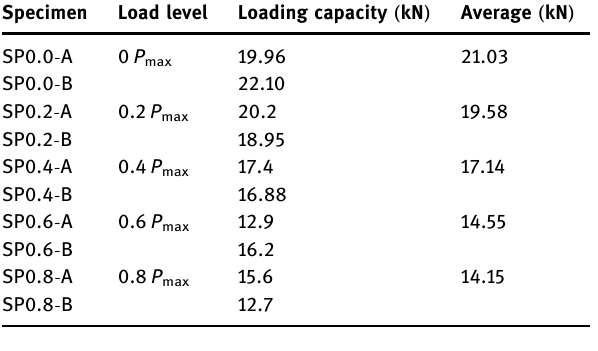
Figure 9: Relationship between reduction ratio in loading capacity of beams and load level.